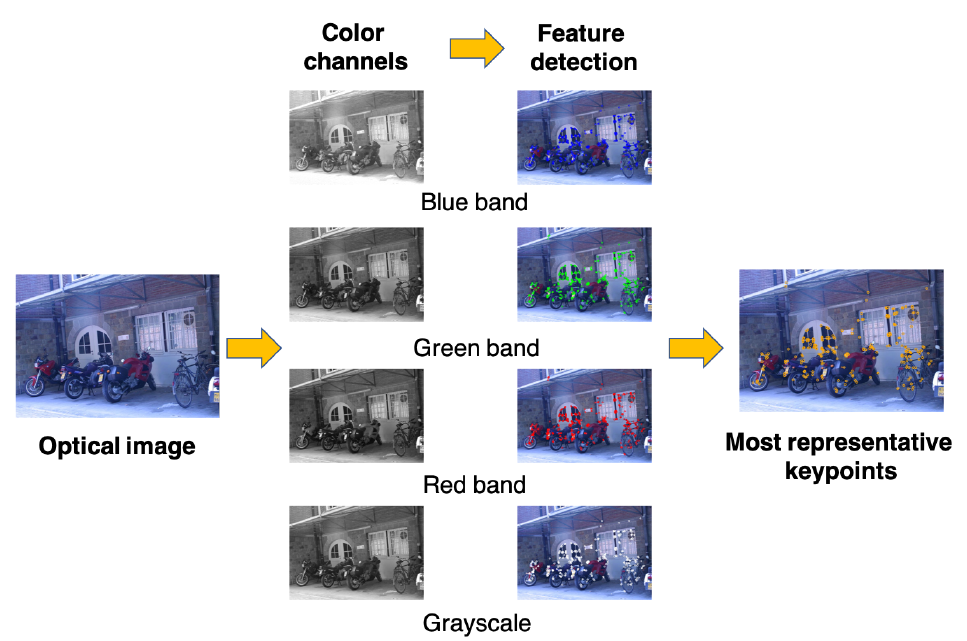
Figure 3. Detecting BRISKs in grayscale and R-G-B channels and finding common keypoints in the four images (image accessed from https://www.robots.ox.ac.uk/~vgg/data/affine/, accessed on 23 January 2021).